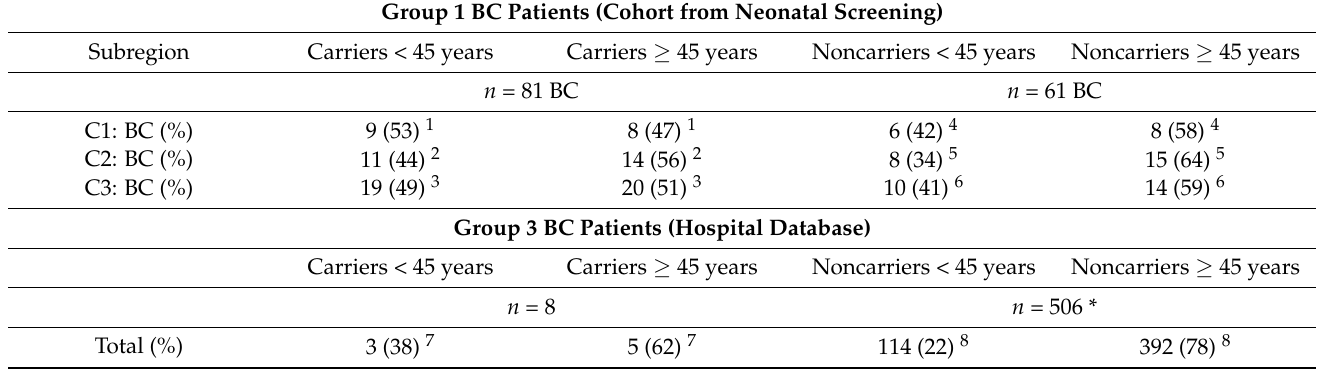
Table 3. Age at diagnosis of breast cancer cases among p.R337H carriers and noncarriers per subregion. Group 1 BC Patients (Cohort from Neonatal